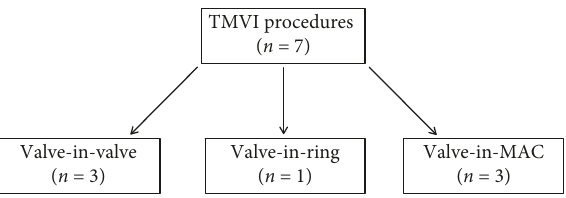
Figure 4: Flow chart of patients treated in this series according to the type of procedure (MAC � mitral annular calcification).